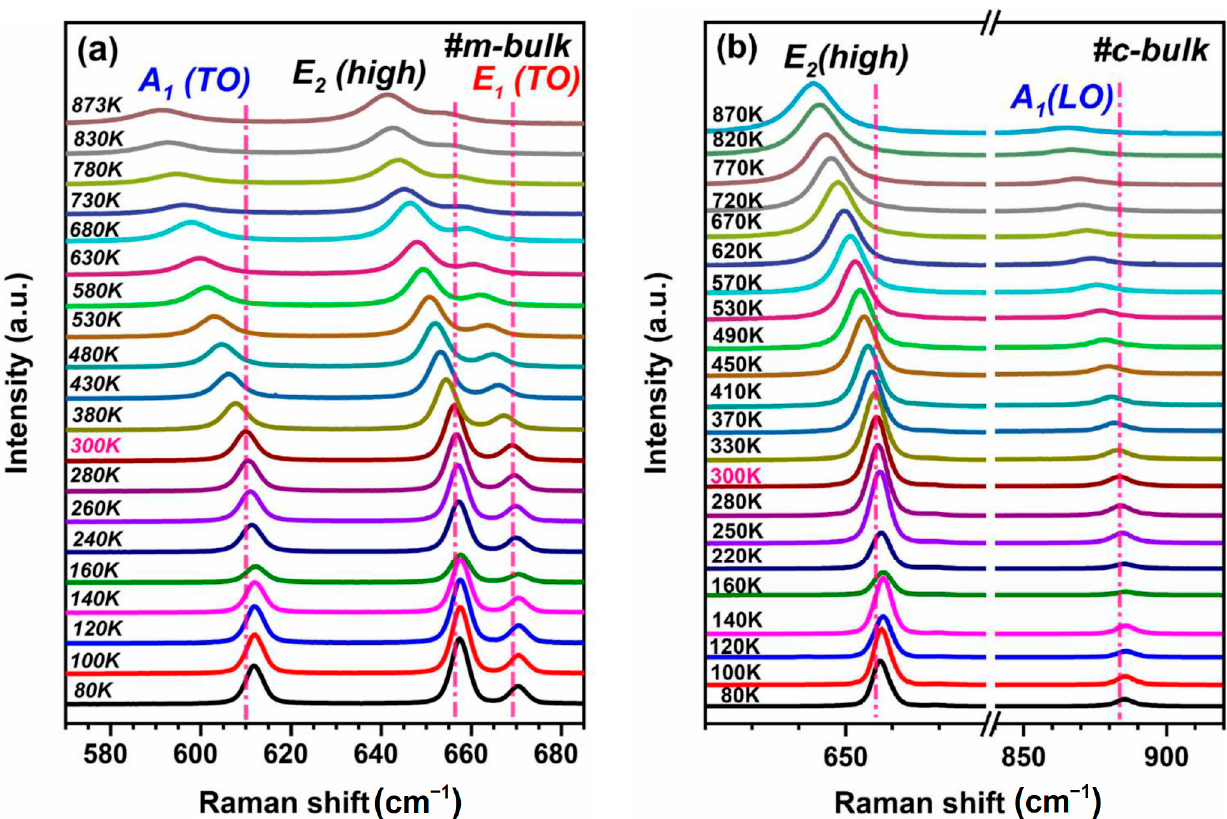
Figure 4. Raman spectra ( a , b ) for m-bulk and c-bulk samples excited by 532 nm laser were taken at different temperatures from 80 to nearly 870 K.